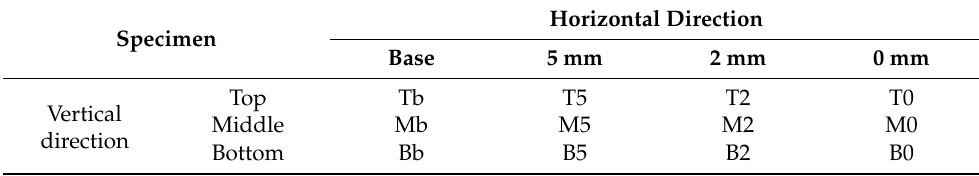
Figure 2. ( a ) Schematic illustration, ( b ) optical images of the welding joint and sampling positions of the specimens. Table 2. Specimen information according to the twelve positions.